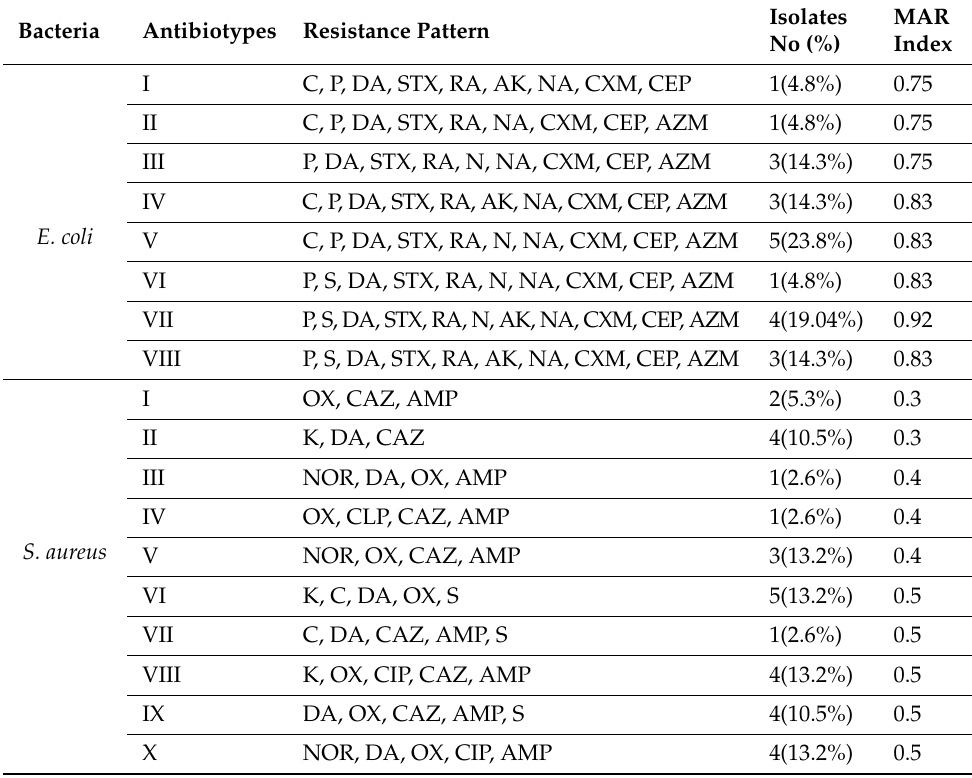
Table 3. Antimicrobial sensitivity pattern and multiple antimicrobial resistance detected in different Escherichia coli and Staphylococcus aureus isolates from clinical and sub-clinical mastitic milk.